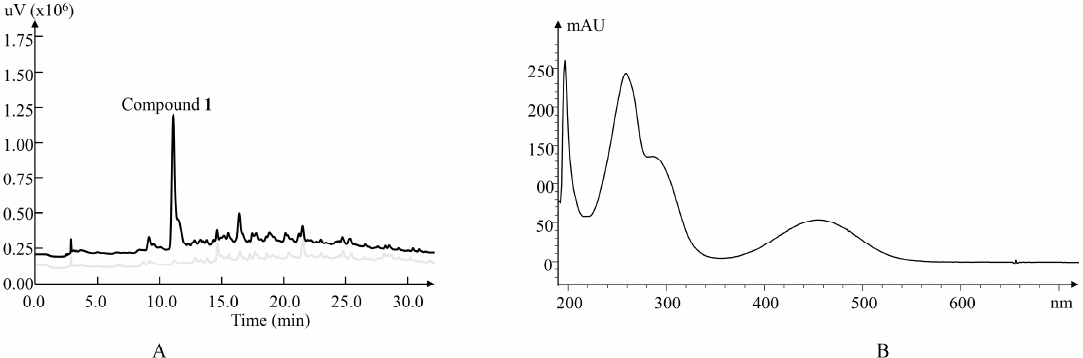
Figure 1. ( A ). HPLC profile of crude extract of the S. albus J1074 mutant (black) and wild-type (gray) strain. ( B ). UV-Vis spectrum of ( 1 ) in MeOH. strain. ( B ). UV-Vis spectrum of ( 1 ) in